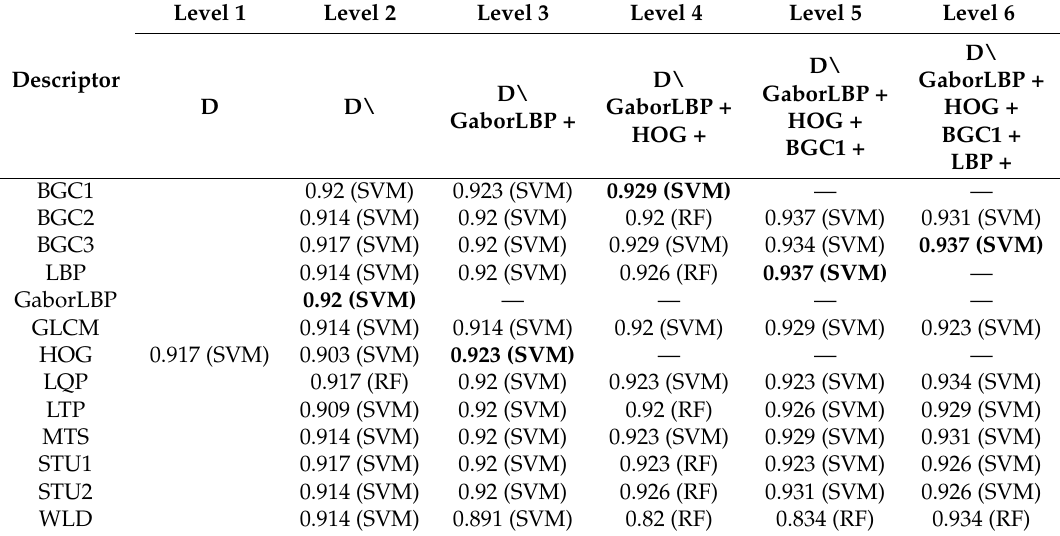
Table 4. Backward Subset Selection of descriptors applied to 1 × 1 gridded image (also known as